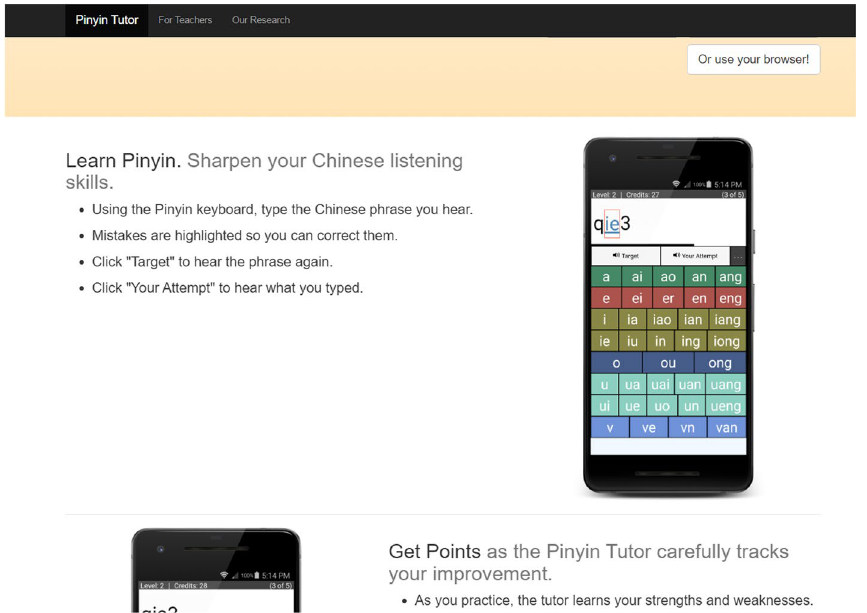
Fig. 1 Snapshot of part of the interface of the Pinyin